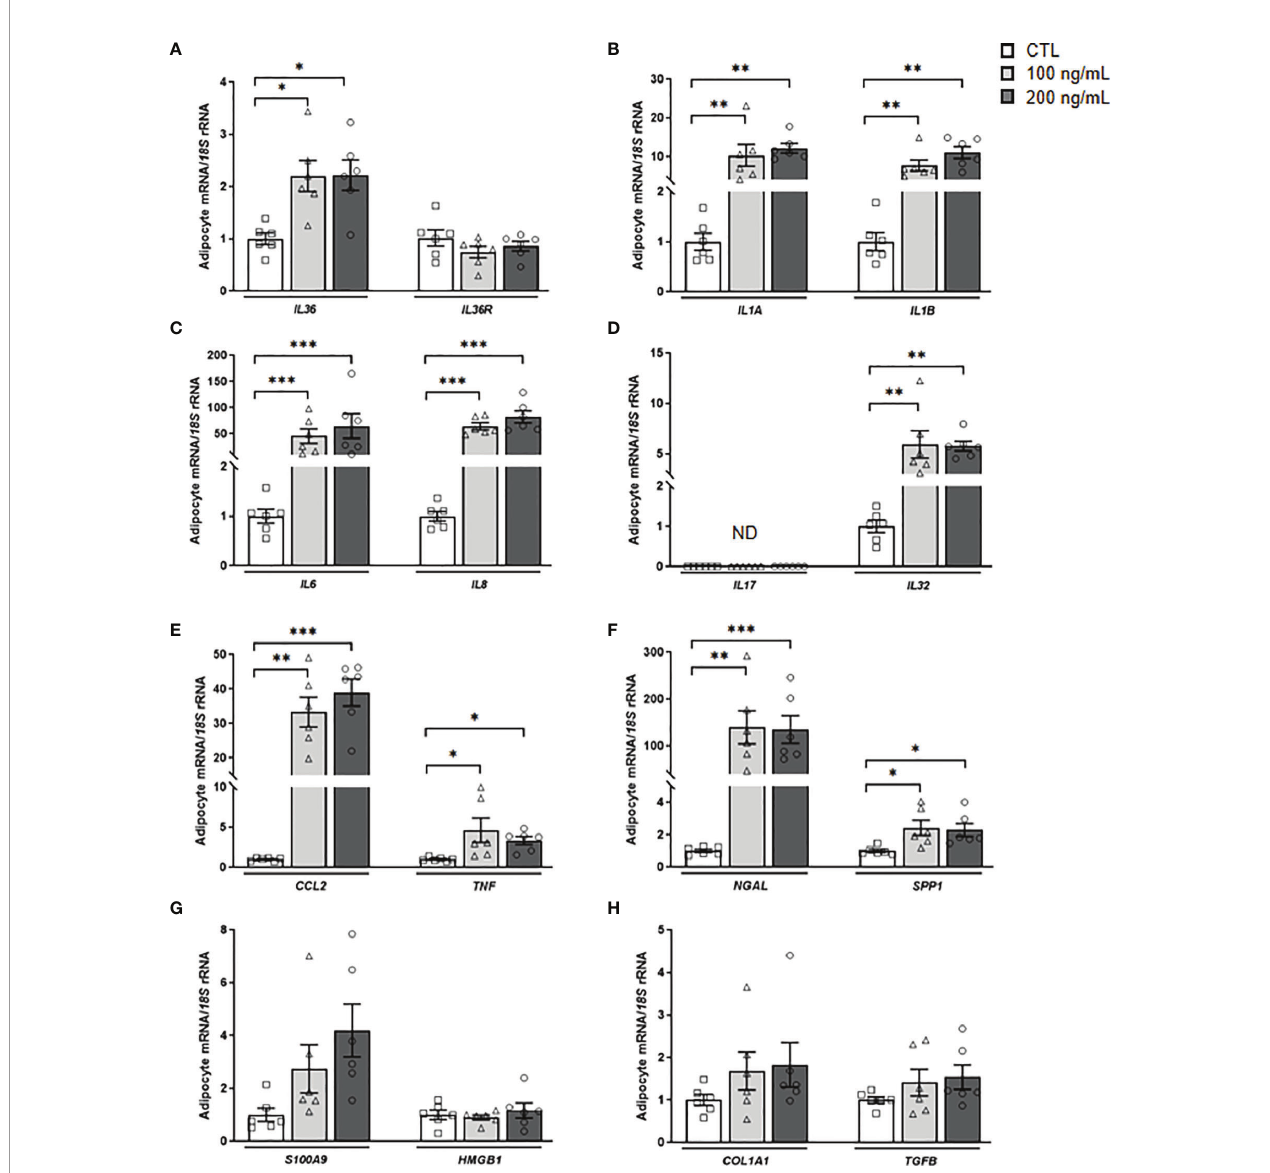
FIGURE 5 | IL-36 g treatment induces its own expression as well as in fl ammatory markers in human visceral adipocytes. Gene expression levels of the pro- in fl ammatory markers (A) IL36G and IL36R , (B) IL1A and IL1B , (C) IL6 and IL8 , (D) IL17 and IL32 , (E) CCL2 and TNF , (F) NGAL and SPP1 , (G) S100A9 and HMGB1 and (H) the fi brosis-associated genes COL1A1 and TGFB in human visceral adipocytes stimulated with recombinant IL-36 g (100 and 200 ng/mL) for 24 h. Gene expression levels in unstimulated cells were assumed to be 1. Values are the mean ± SEM (n=6 per group). Differences between groups were analyzed by one-way ANOVA followed by Tukey ’ s tests. * P < 0.05, ** P < 0.01 and *** P < 0.001. CCL2 , monocyte chemoattractant protein-1; COL1A1 , collagen 1A1; HMGB1 , high mobility group box 1; IL , interleukin; NGAL , lipocalin 2; S100A9 , S100 calcium-binding A9; SPP1 , osteopontin; TGFB , transforming growth factor- b TNF , tumor necrosis factor- a